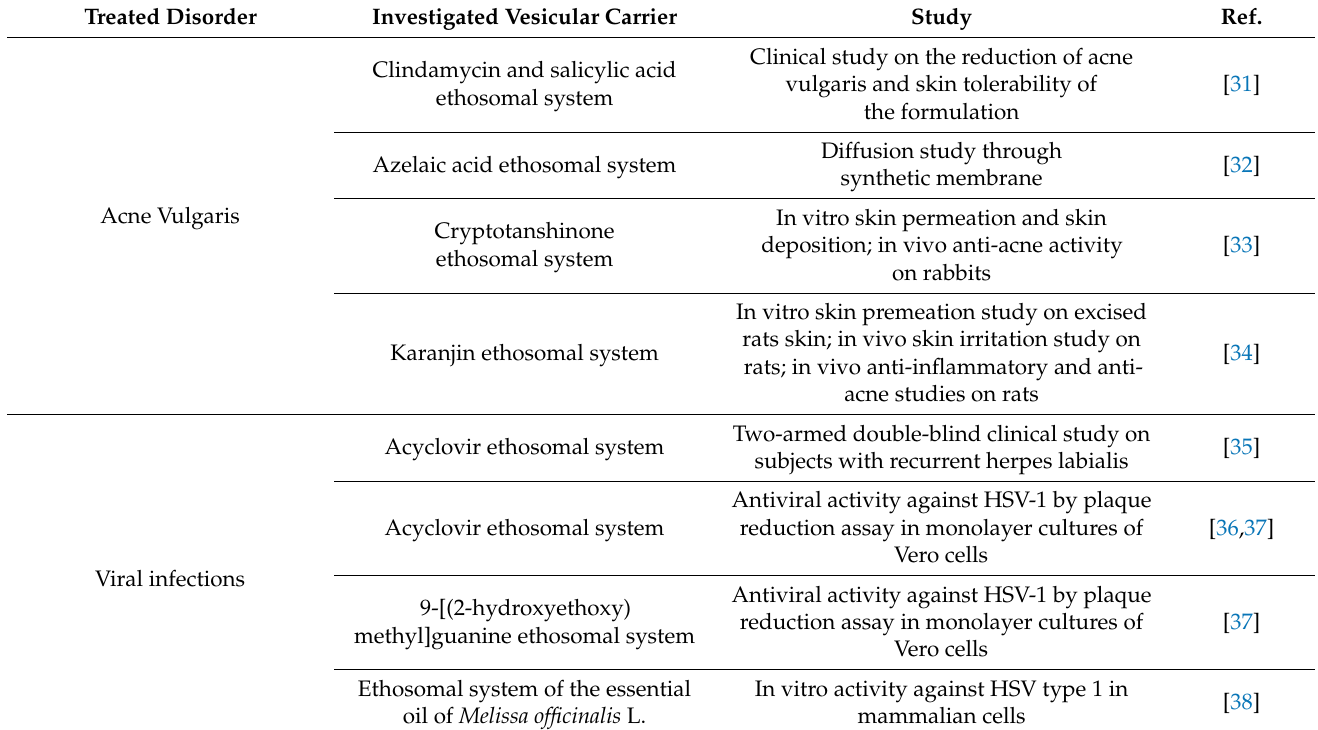
Table 1. Skin disorders treated with active molecules incorporated in carriers containing phospholipid soft vesicles. Treated